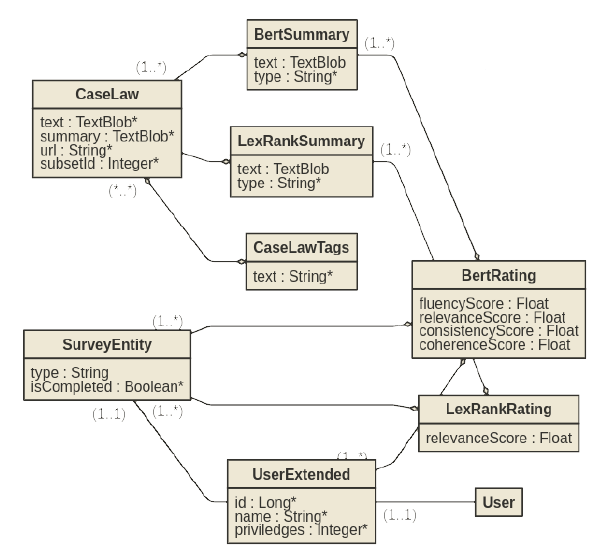
Figure A1. A schema of the entity fields and the cross-entity relationships in our database. Having defined the database model, we generated a RESTful API that corresponds to